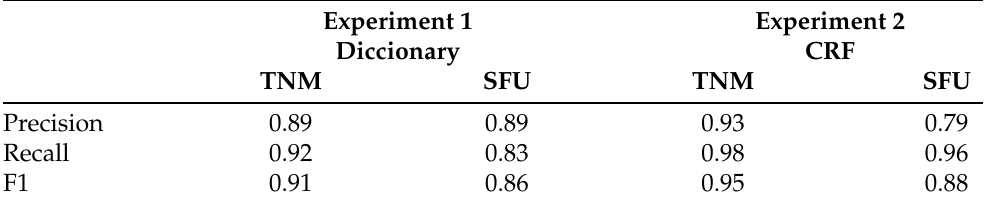
Figure 4. Ten most frequent negation in both T-MexNeg corpus (represented in blue) and SFU Review SP -NEG corpus (represented in orange). Table 6. Results for negation cue detection using dictionary and CRF approaches on TNM and SFU